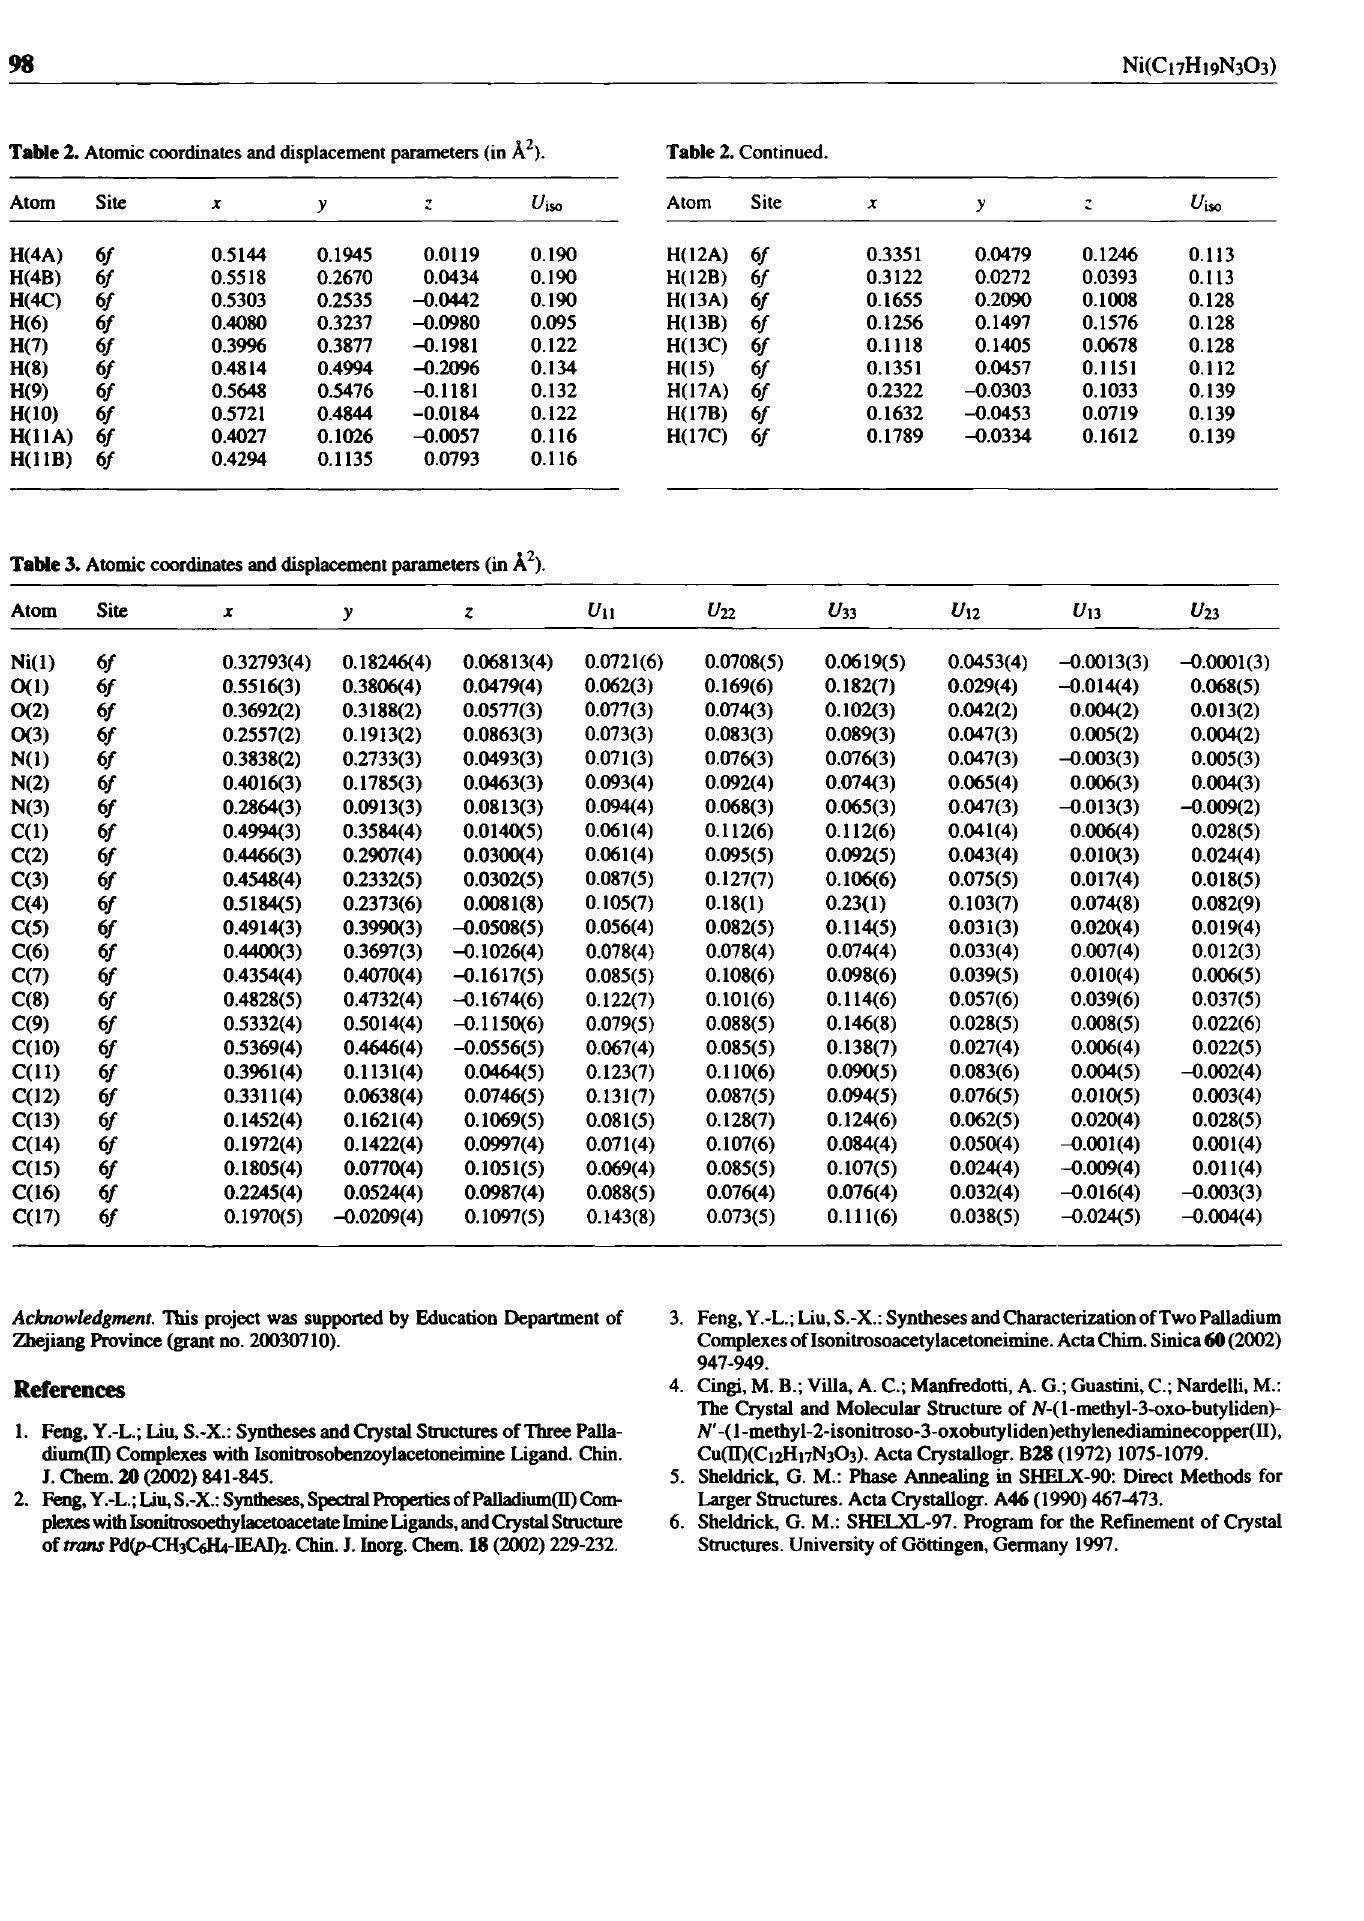
Table 2. Atomic coordinates and displacement parameters (in Ä 2 ).